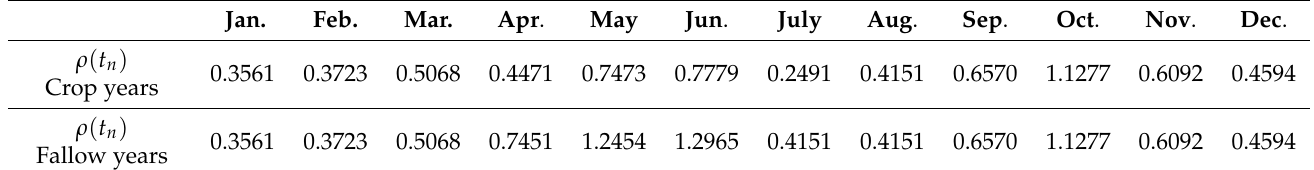
Table 2. Monthly values for ρ for the Hoosfield spring barley experiment, estimated from weather data in [6], clay content of 23.4% and soil cover factors in crop and fallow